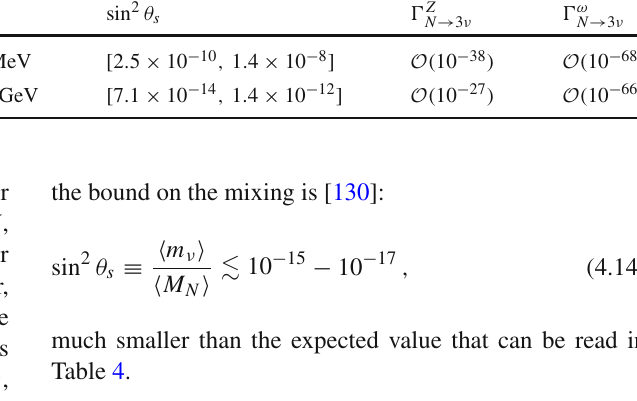
Table 4 Expectation for the heavy neutrino mass and mixing between heavy and active